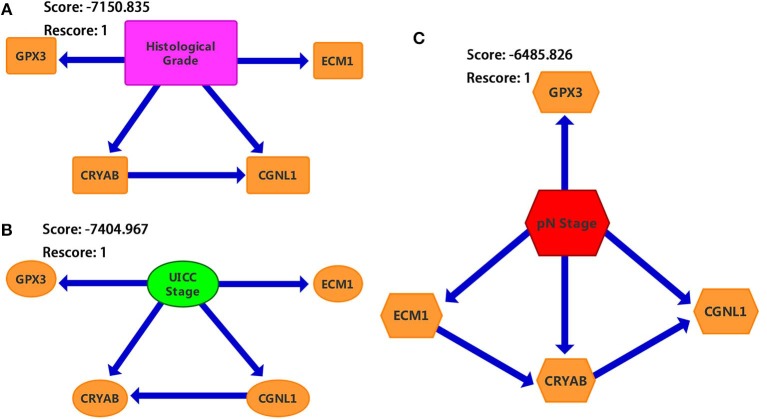
Bayesian networks (BNs) based on ECM1, GPX3, CRYAB, and CGNL1 with bladder urothelial carcinoma (BC). (A) Histological grade; (B) UICC (Union for International Cancer Control) stage; and (C) pN (pathological N) stage.